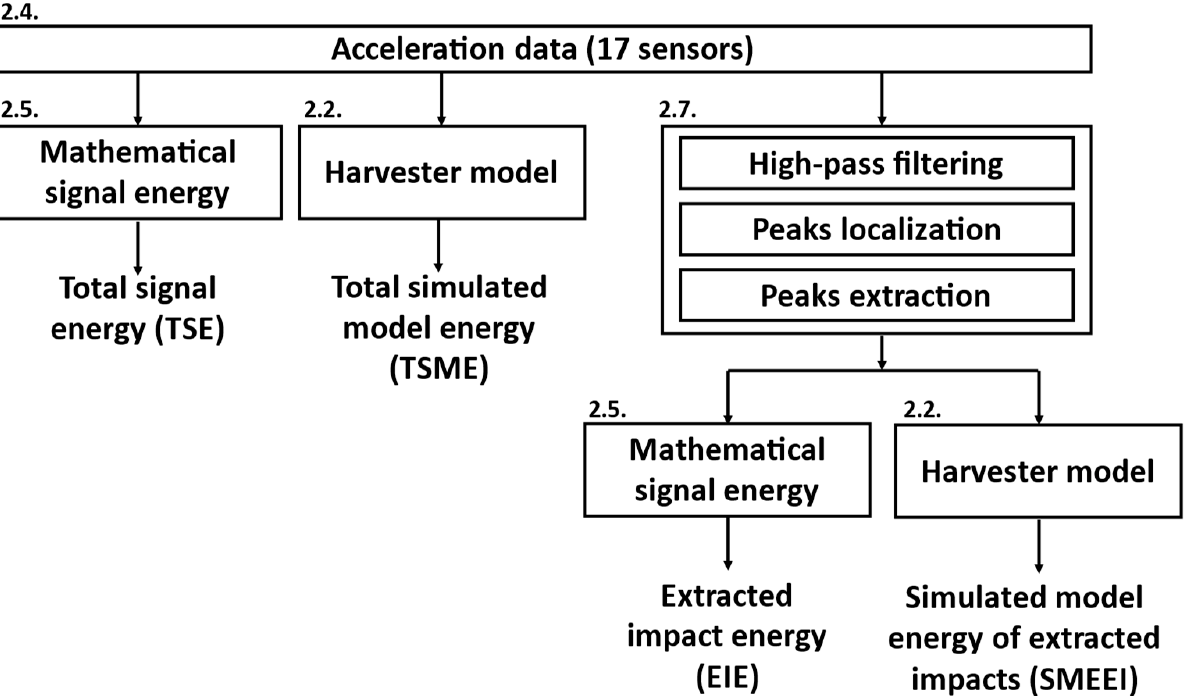
Figure 4. Flowchart of impact evaluation. The first step consists of calculating the mathematical signal energy and simulating the harvester model energy, using the total acceleration data. The second step consists of extracting the impacts from the acceleration data, and then calculating the new mathematical signal energy and simulating the new harvester model energy. The numbers displayed above the blocks represent the paper sections where the method is discussed.